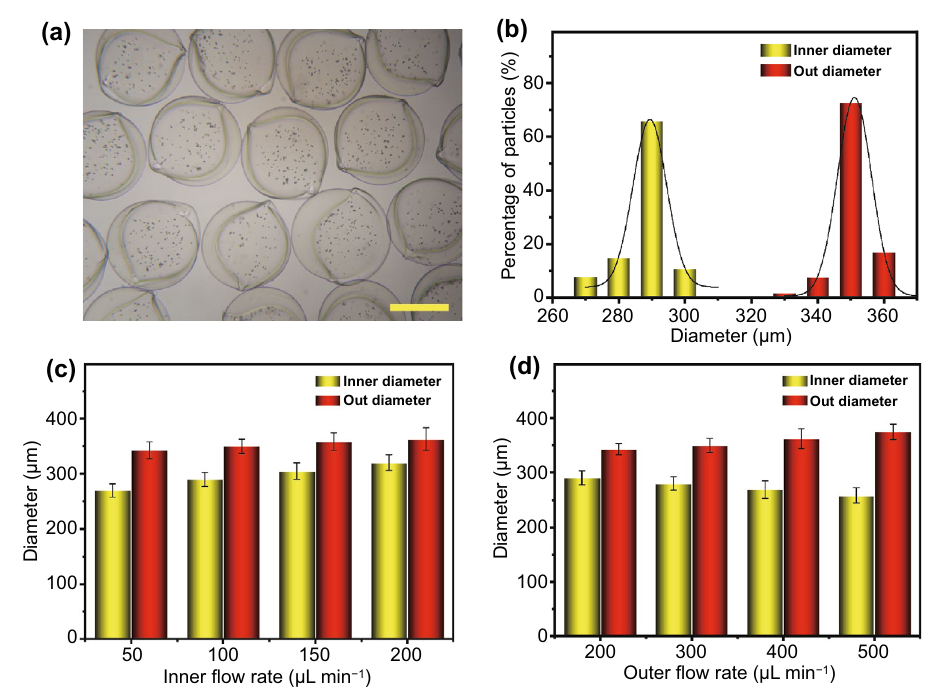
Fig. 3 Factors controlling the microcapsules size. a , b The morphology ( a ) and size distribution ( b ) of produced microcapsules. c , d The rela- tionship of inner ( c ) and outer ( d ) phase flow rates on microcapsules size. The scale bar is 200